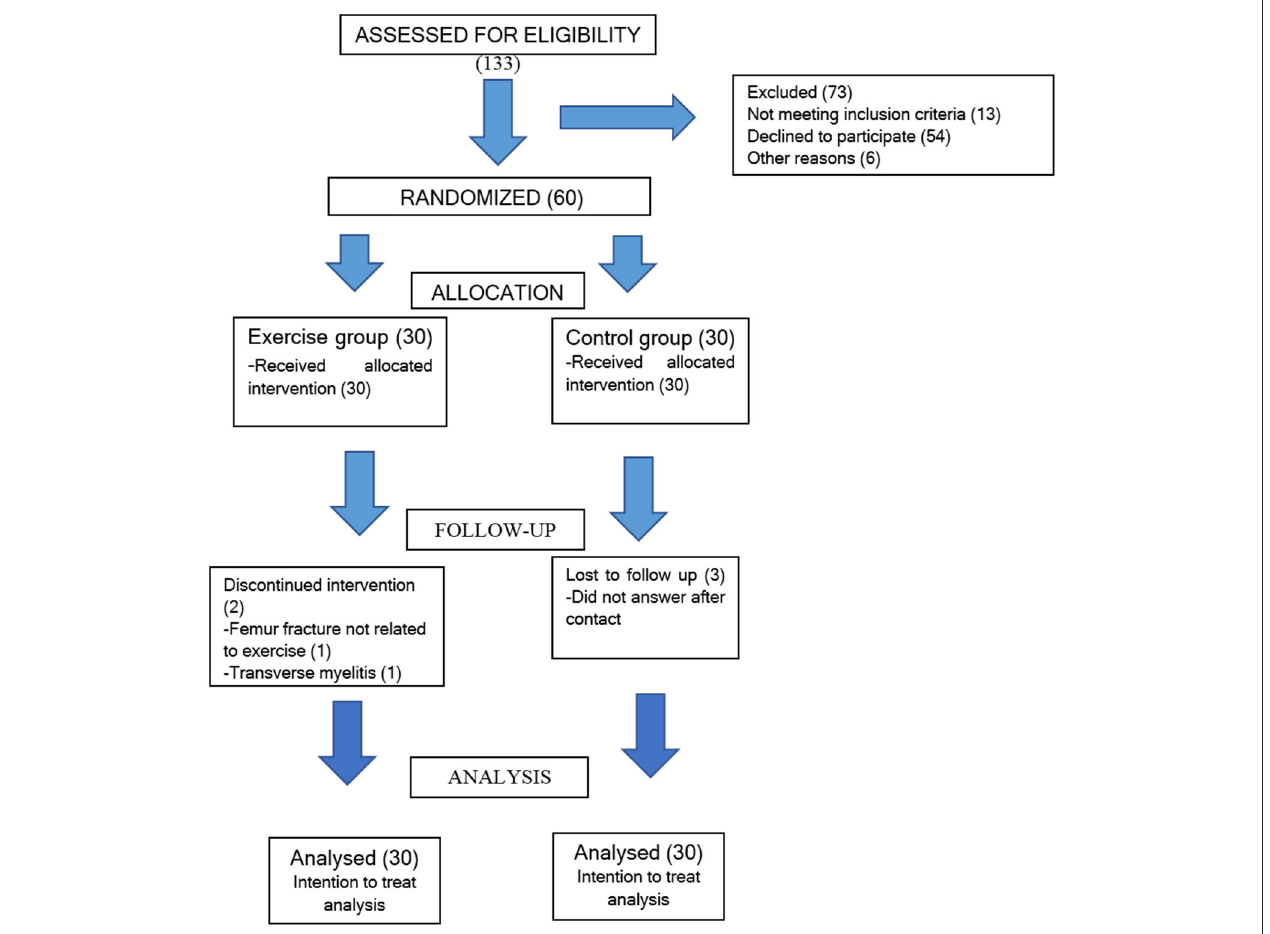
FIGURE 1 | Flow diagram of participants through each stage of the